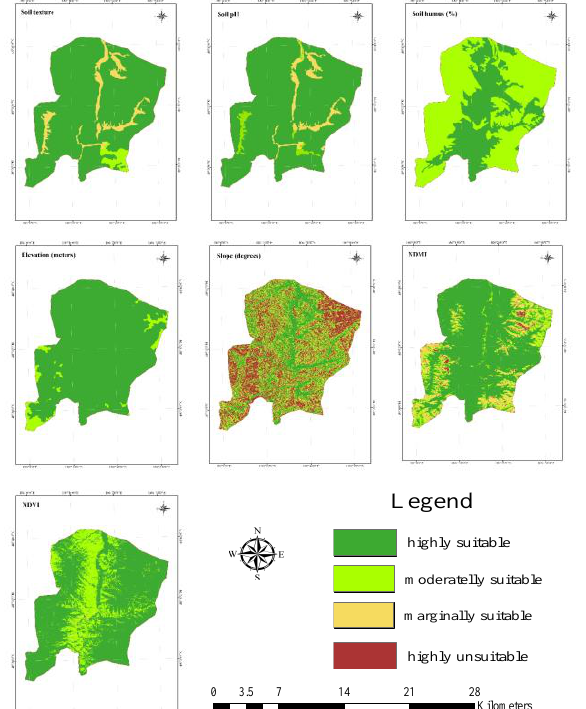
Figure 4. Criteria maps for the cropland suitability which as classified via table 3.